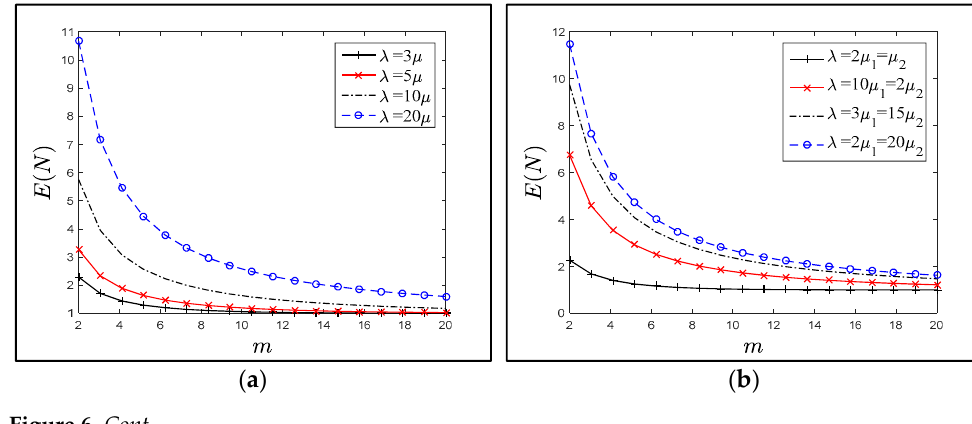
( c ) Figure 6. Effect of SAPs on the expected LAPs when the residence time is distributed as in ( a – c ). ( a ) Exponentially distributed residence time with mean